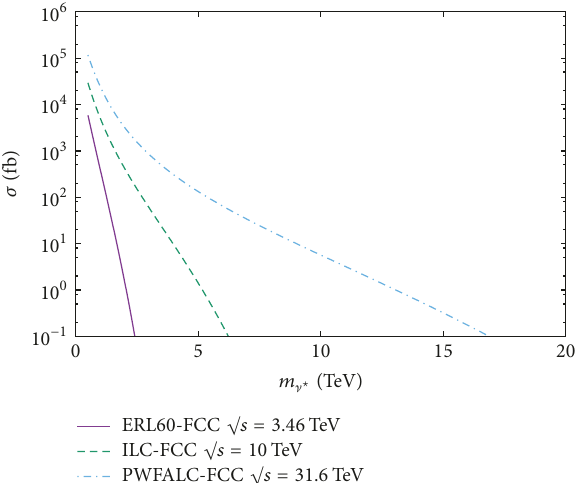
Figure 3: The total cross sections as a function of the excited neu- trino mass at the 𝑒𝑝 colliders with various center-of-mass energies, assuming 𝑓 = 𝑓 󸀠 = 1 and Λ = 𝑚 ] ⋆